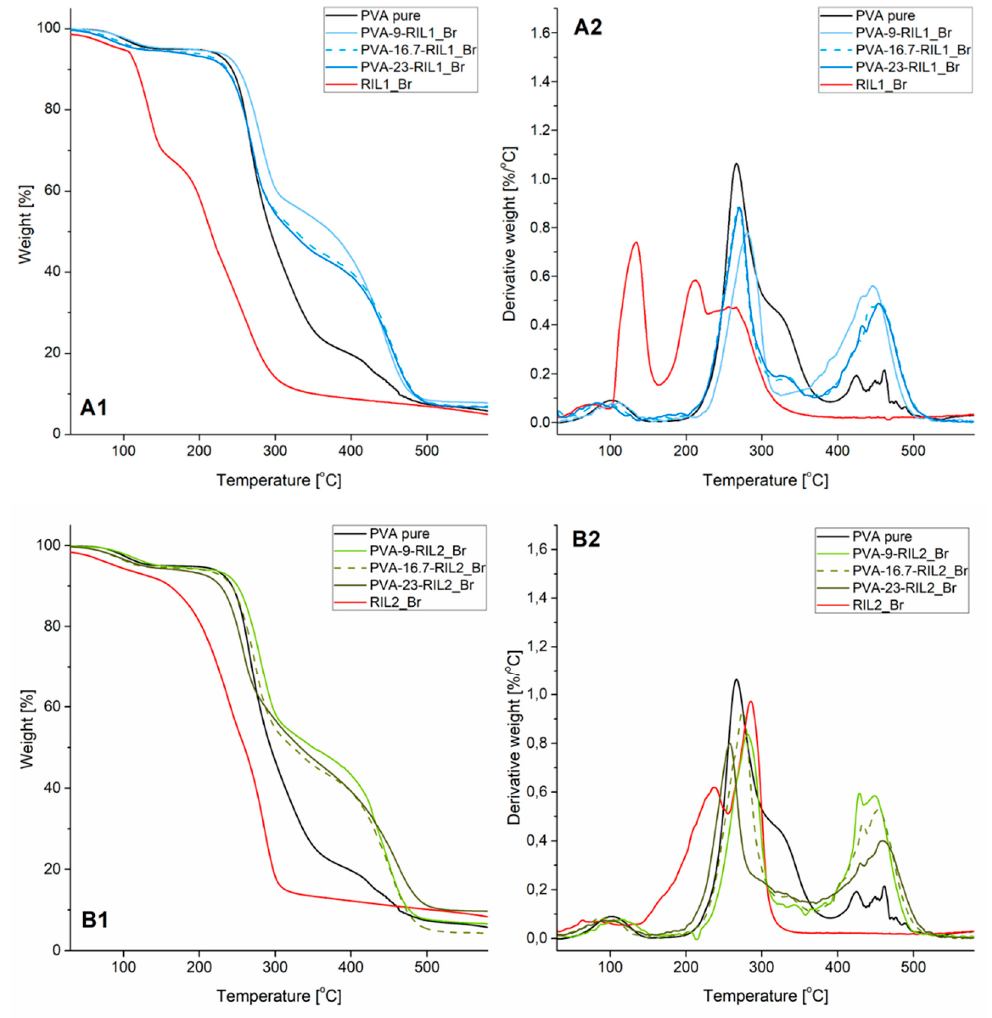
Figure 5. Thermogravimetric (TG) ( A1 , B1 ) and derivative thermogravimetry (DTG) ( A2 , B2 ) analysis of PVA-RIL films. Polymers 2020 , 12 , x FOR PEER REVIEW